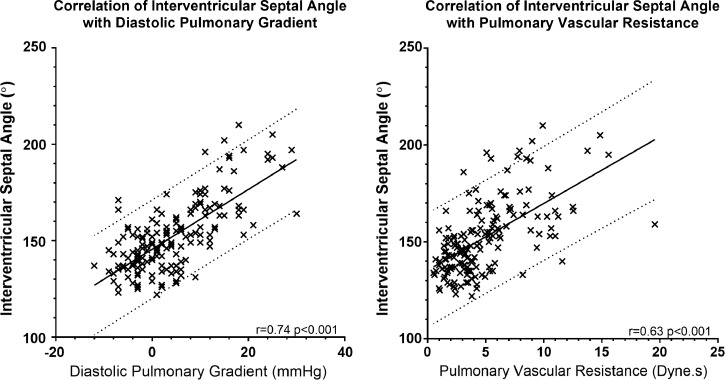
Scatterplots show the correlation of systolic interventricular septal
angle with diastolic pulmonary pressure gradient and pulmonary vascular
resistance. Solid line represents the line of best fit, and dotted lines
represent 95% confidence intervals.